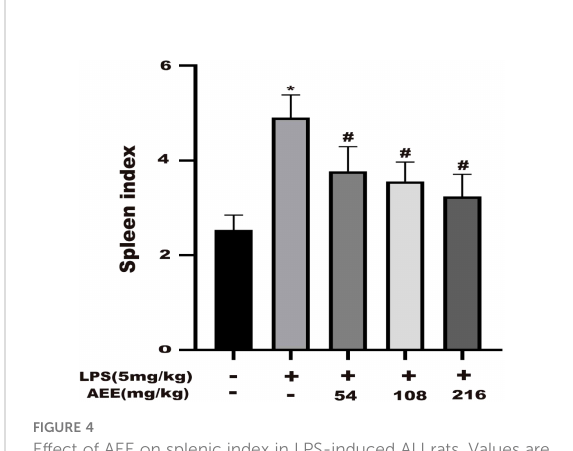
FIGURE 5 Effect of AEE on lung wet to dry weight ratio (W/D). Values are presented as the means ± SD where applicable ( n = 8). * P < 0.05 compared to control group, # P < 0.05 compared to LPS